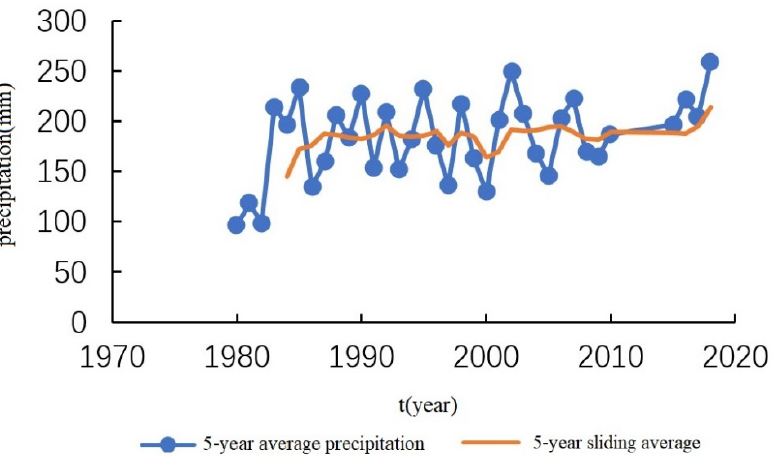
Figure 6. Annual average precipitation trend in the northern Yellow Diversion Irrigation Area.